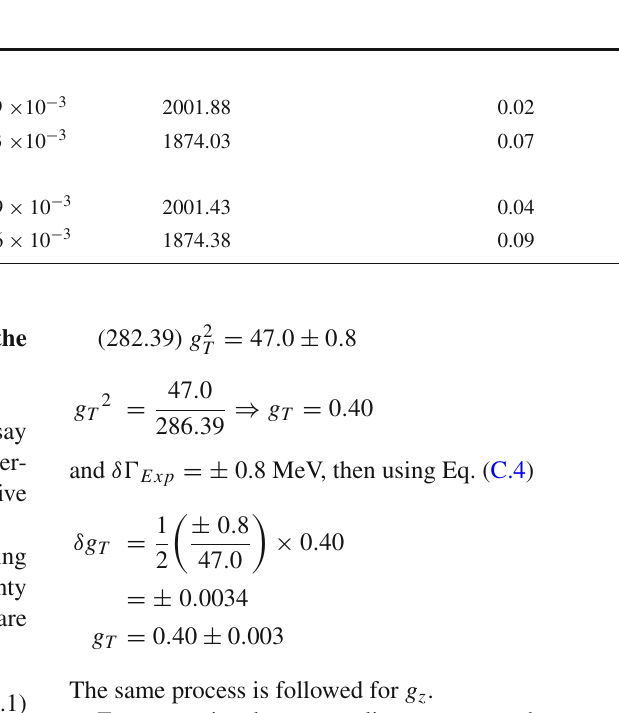
Table 17 The effect on 1 S mass (in MeV) after % change in the potential parameters Change in λ